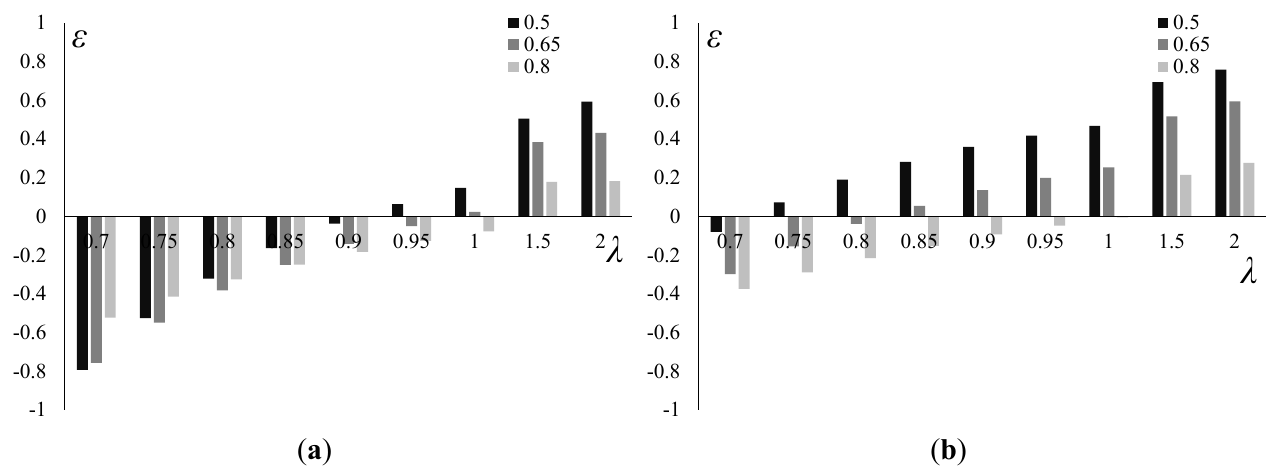
Figure 6. Error in Equation (23) calculated considering energies above a certain fraction of the storm peak for various EPS shapes: ( a ) the buoy 42001; and ( b ) the buoy 46006.